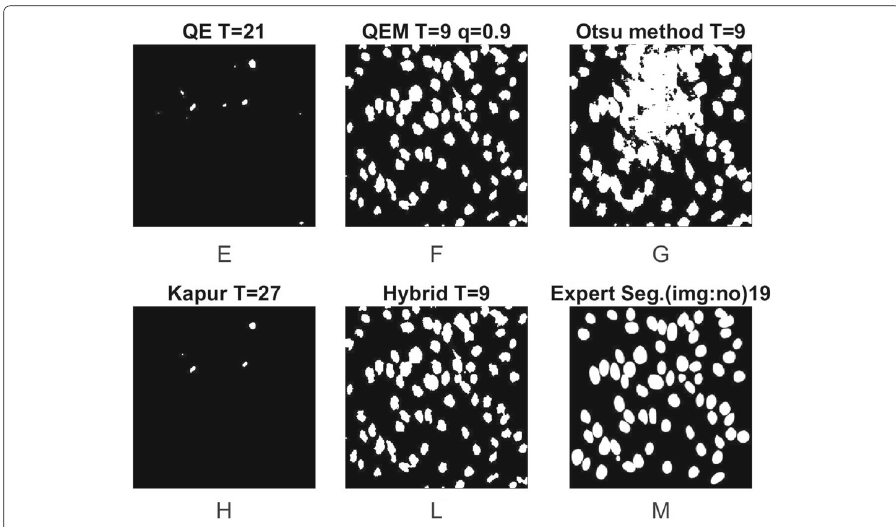
Fig. 8 F-measure = [0.0287 0.7988 0.7178 0.01869 0.7988] for quantum entropy, modified quantum entropy (proposed), Otsu, Kapur, and Hybrid of the proposed with the Otsu methods,